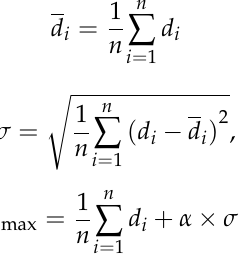
Figure 6. Point cloud data after filtering. 3. 3D Vehicle-Detection Algorithm 3.1. General Idea of the Algorithm To address the diversity and complexity of vehicle features, this study introduced a deep neural network to implement vehicle detection. The algorithm framework is shown in Figure 7. At first, the preprocessed point cloud and image information were used for feature extraction using ResNet [25] and multiple views with the same aspect ratio were obtained for feature matching by scaling the size of the point cloud and image feature map. Then, the multimodal feature fusion module was introduced to perform a pixel-by- pixel averaging operation on the multimodal features to achieve multimodal feature fu- sion, and the feature pyramid [26] was added to extract higher-order features. Finally, the higher-order features were entered into the detection frame generation module and ag- gregated with the cropped view to generate a 3D vehicle-detection frame.